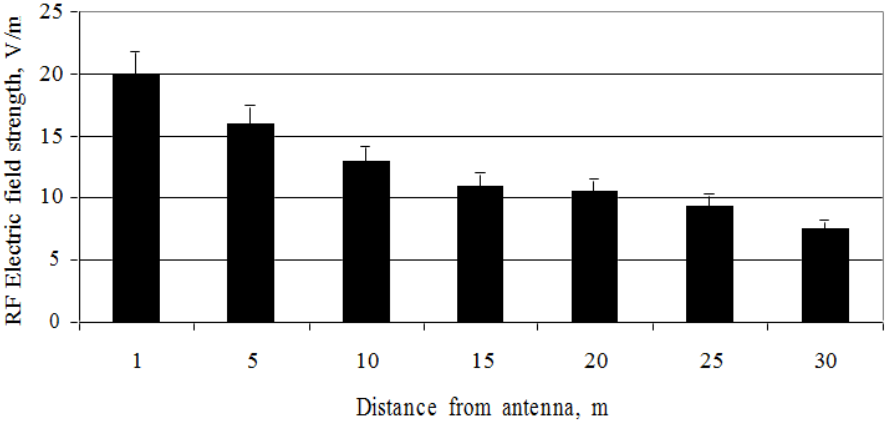
Figure 7. Distribution of the RF electric field strength of mobile telephony base station antenna (ERP = 1739 W) at different distances.